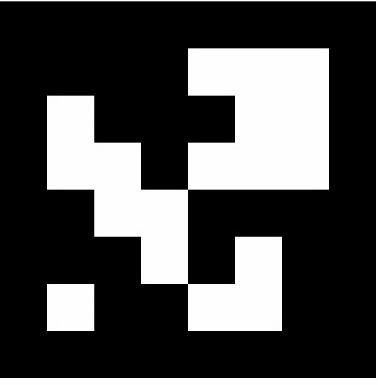
Figure 2. The example of ArUco